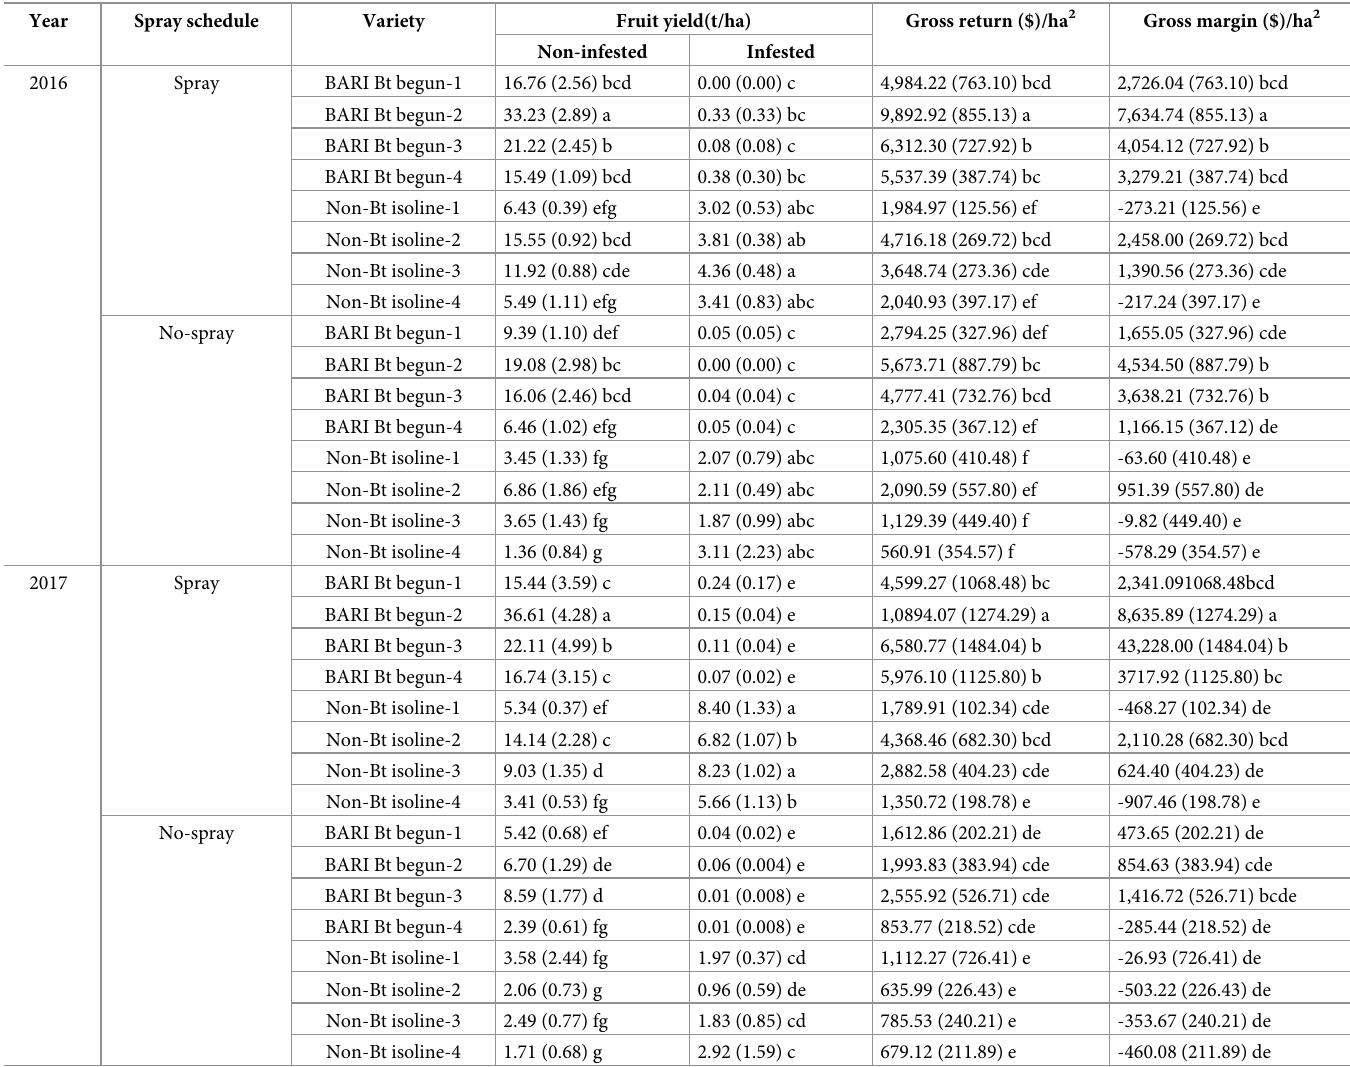
Table 2. Mean yields 1 and economic returns for brinjal by brinjal shoot and fruit borer (BFSB) relative to insecticides and variety, OFRD, BARI, Bogra,